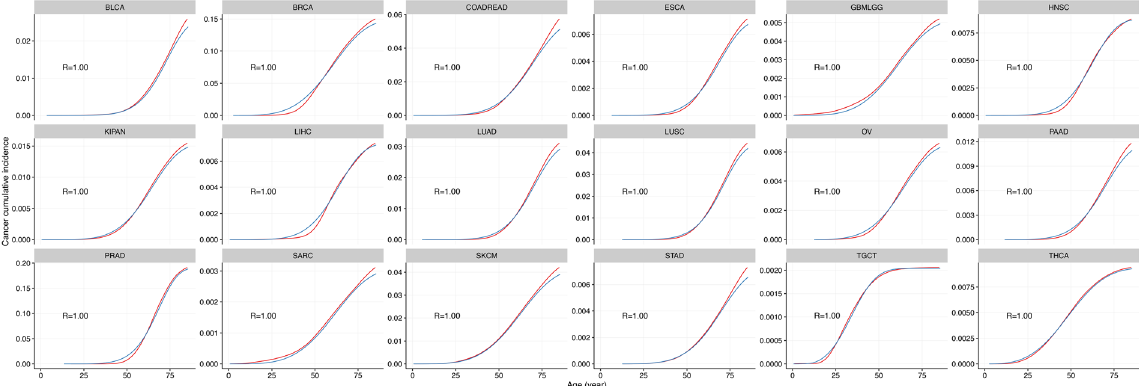
Figure 1. Empirical cumulative cancer incidence data are consistent with the Weibull cumulative probability function in 18 cancers (data for ages up to 85 years old). Empirical (blue line) and Weibull function-fitted (red line) cancer cumulative incidence curves for 18 tissues, goodness of fit is reported in each subplot. The 18 cancers exhibit a good goodness of fit when using R 2 between model-reported age incidence and the empirical cumulative cancer incidence are used as